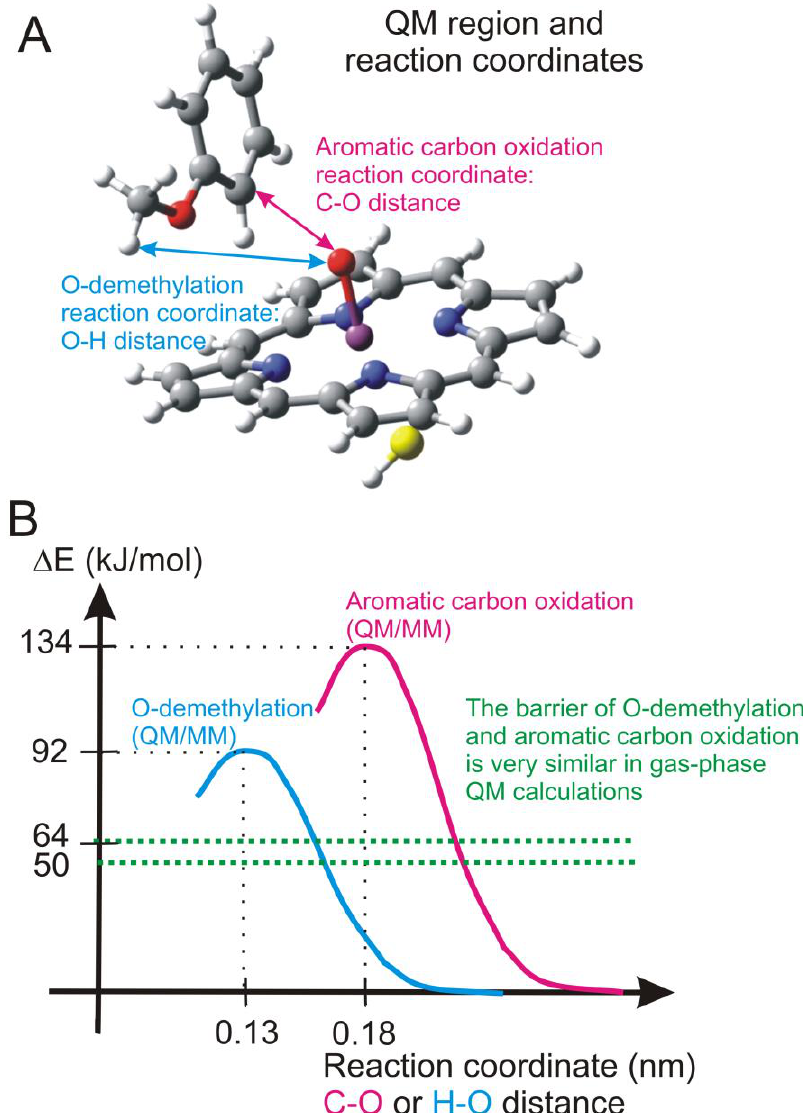
Figure 15. ( a ) QM region used in the calculations ( b ) Barriers of O-demethylation and aromatic carbon oxidation obtained from quantum mechanical and QM/MM